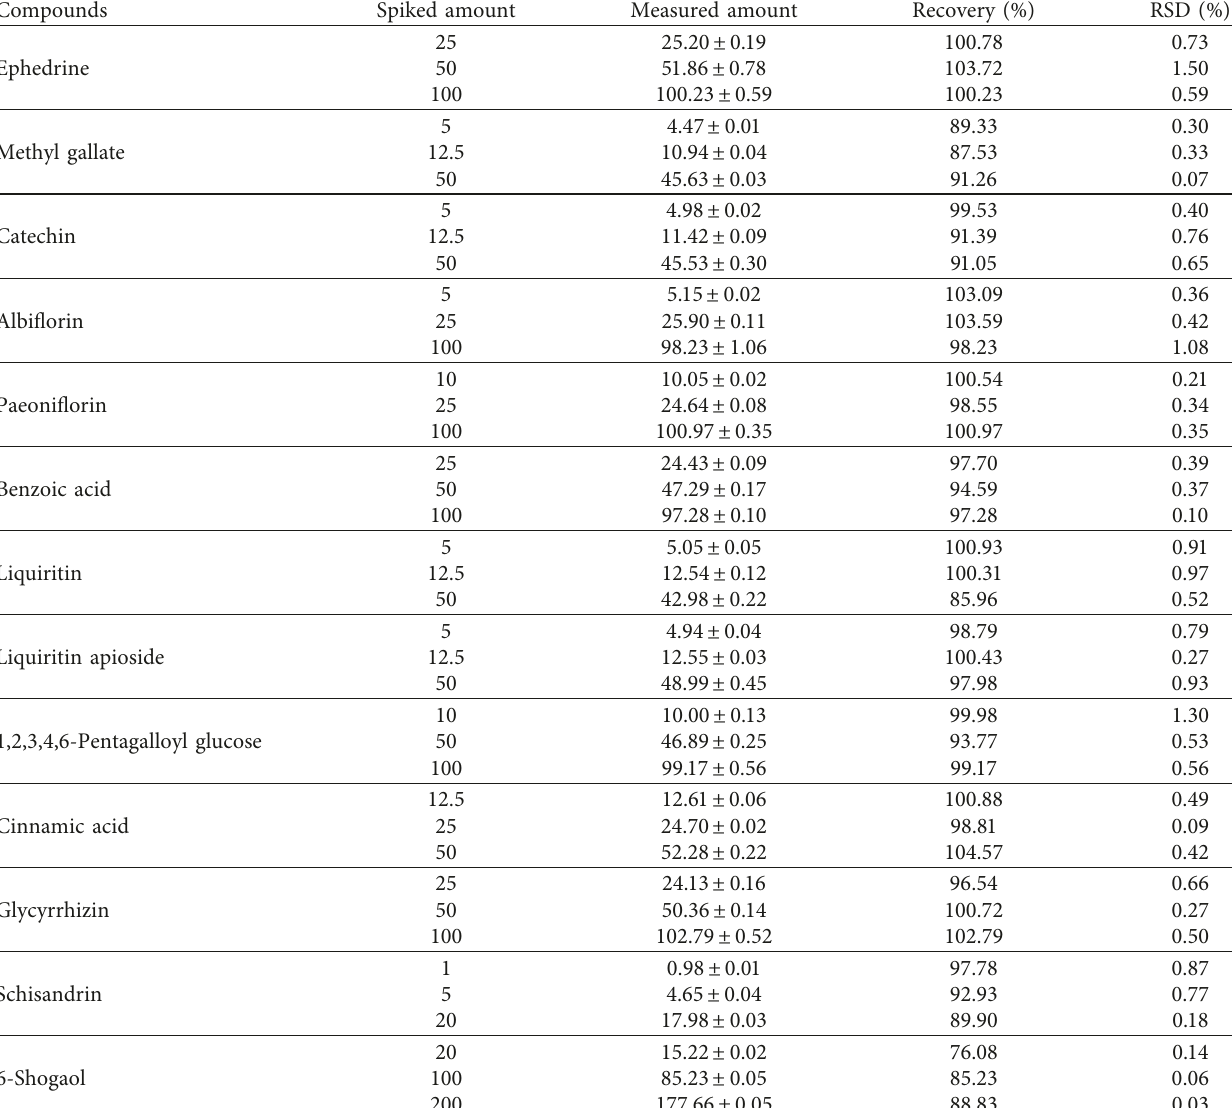
Table 3: Determination of recoveries of the 13 compounds (1–13) in